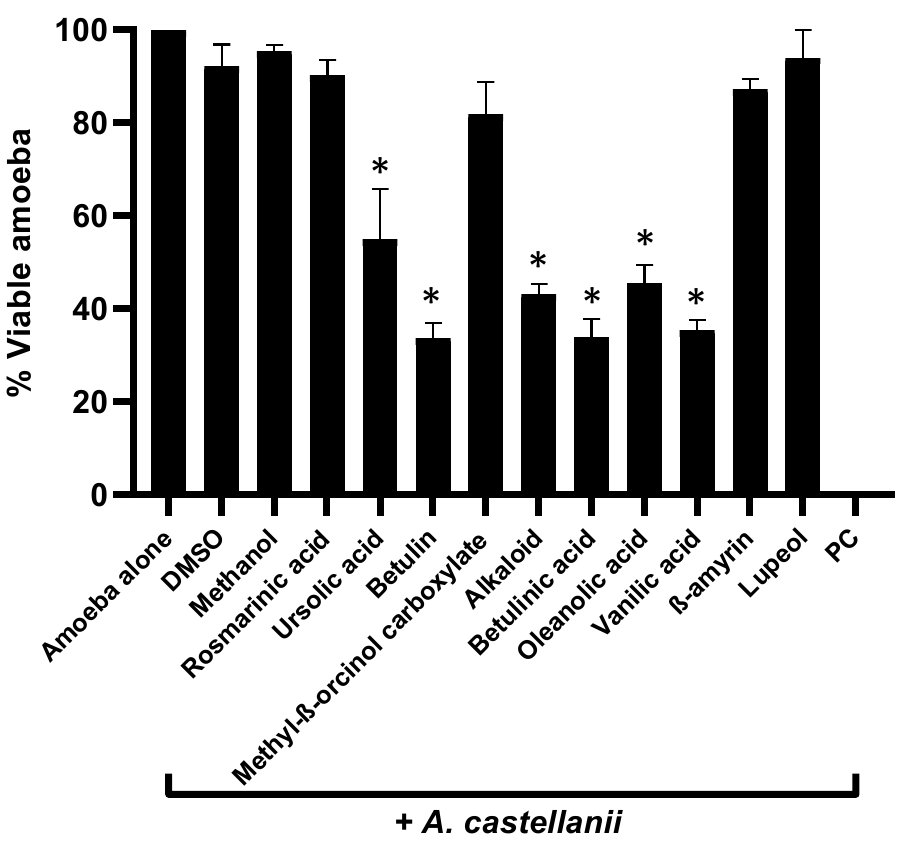
Figure 2. Compounds isolated from medicinal plants presented notable amoebicidal activities against amoeba. Briefly, isolated compounds at a concentration of 100 µg/mL were incubated with 5 × 10 5 of A. castellanii overnight, at 30 °C. Following this, viable amoebae were calculated using haemocytometer microscopically. The data are expressed as the mean ± standard error. p values were determined using two-sample t -test, two-tailed distribution, (*) is p < 0.05.